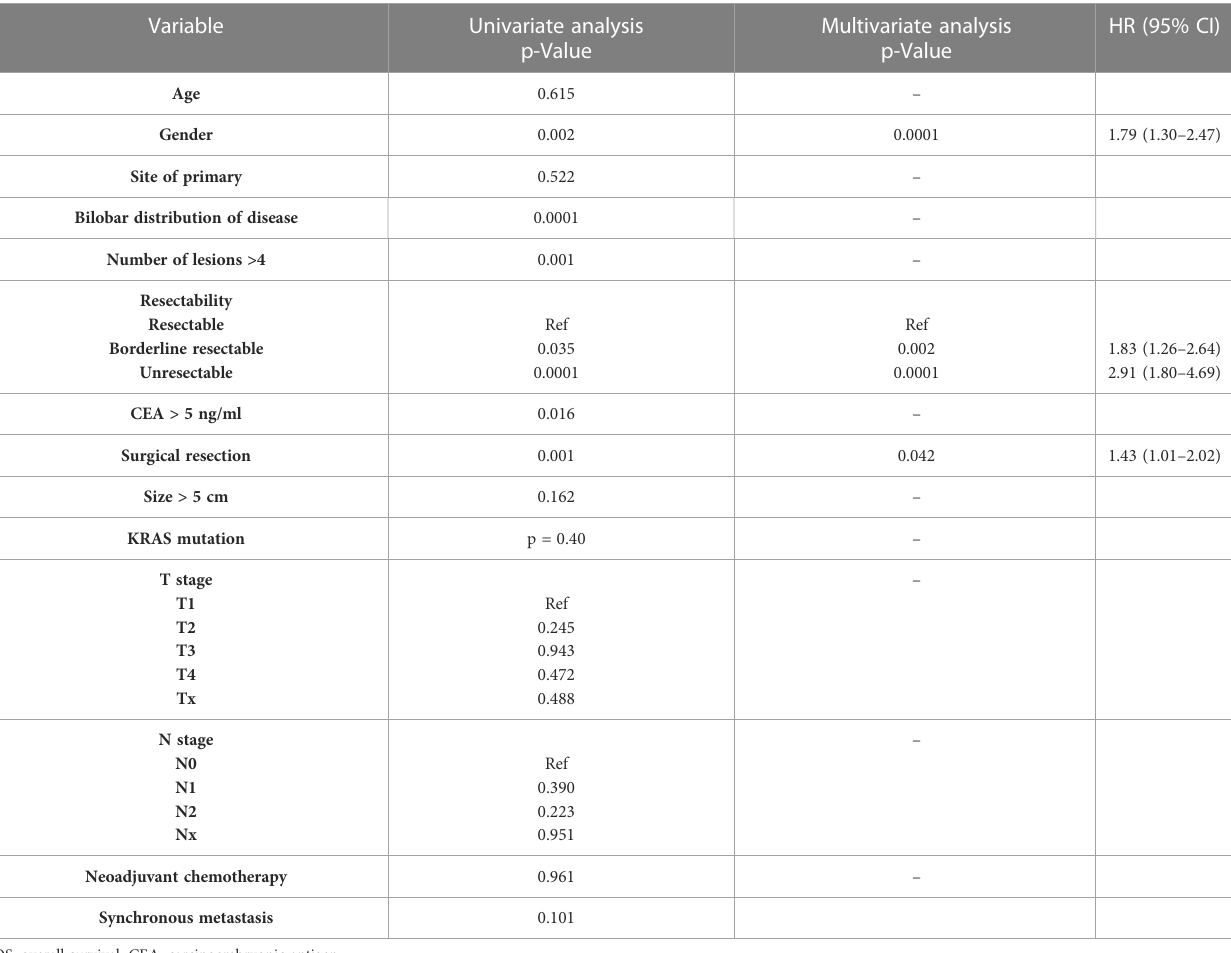
TABLE 3 Factors affecting OS: univariate and multivariate